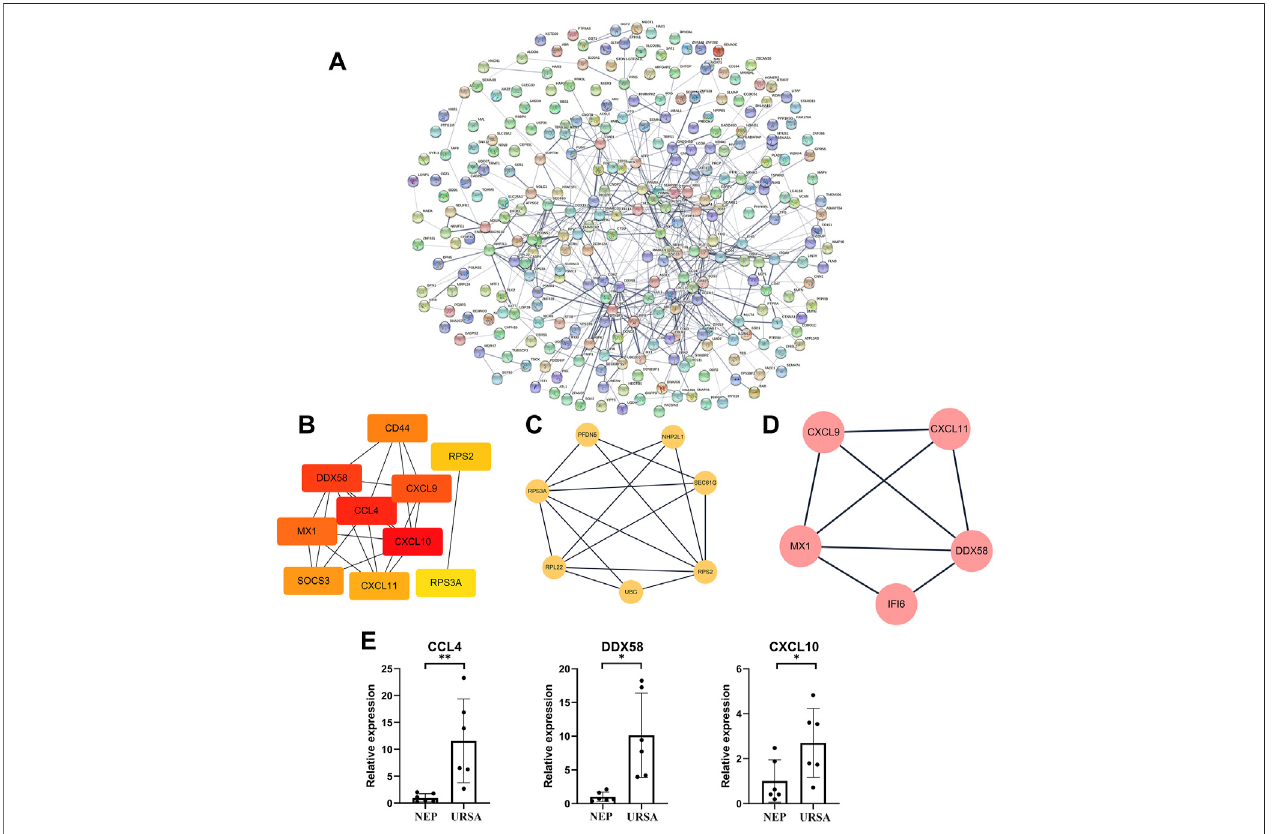
FIGURE 3 | PPI network analysis of DE mRNAs and validation of mRNA-Seq data. (A) The PPI network of DE mRNAs. (B) The subnet involving the top 10 DEGs (hub genes) with high connectivity degrees obtained from the PPI network. (C,D) The top 2 signi fi cant modules were obtained from the PPI network. (E) The relative expression levels of three mRNAs in the PPI network were validated by RT-qPCR. * p < 0.05, ** p <